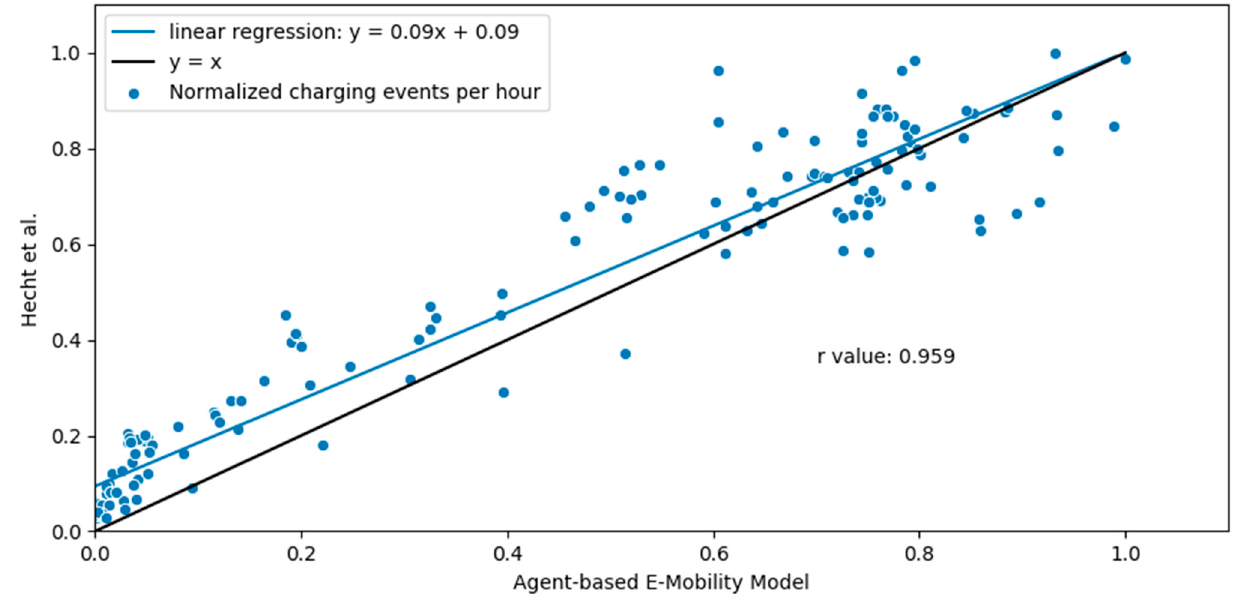
Figure A5. Correlation of normalized mean values per hour of measured charging events from Hecht et al. 2020 [40] and the Agent-based e-Mobility Model over the course of a week.